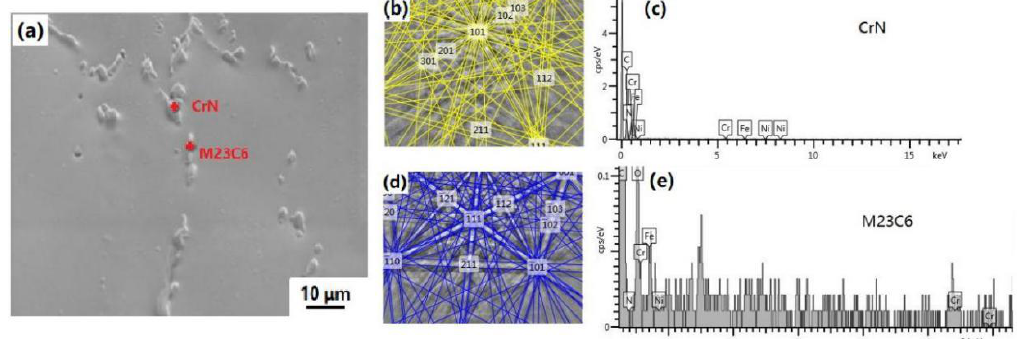
Figure 17. EBSD images of dots with ε = 1 s − 1 and 20% height reduction at 1373 K. : ( a ) electronic image, ( b ) kikuchi Line of CrN, ( c ) energy spectrum of CrN, ( d ) kikuchi Line of M 23 C 6 and ( e ) energy spectrum of M 23 C 6 .